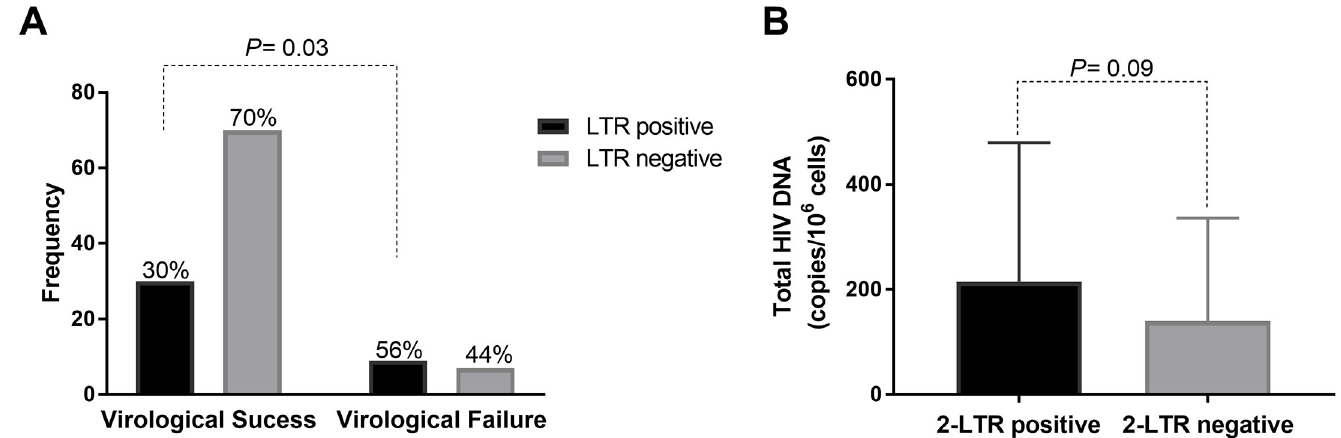
Fig 2. (A) Frequency of 2-LTR positive samples among patients with virologic success and virologic failure. (B) Mean levels of total HIV DNA in 2-LTR positive and negative samples. Bars show standard deviation. https://doi.org/10.1371/journal.pone.0217502.g002 increase in positivity when compared to salvage therapy with PI ( χ 2 (1) = 4.038, p = 0.044) (Fig 3). There was no significant difference between the first-line regimen groups and the sal- vage therapy groups, ( χ 2 (1) = 0.360, p = 0.34) nor any difference when comparing groups with or without virologic failure ( χ 2 (1) = 1.945, p = 0.13).